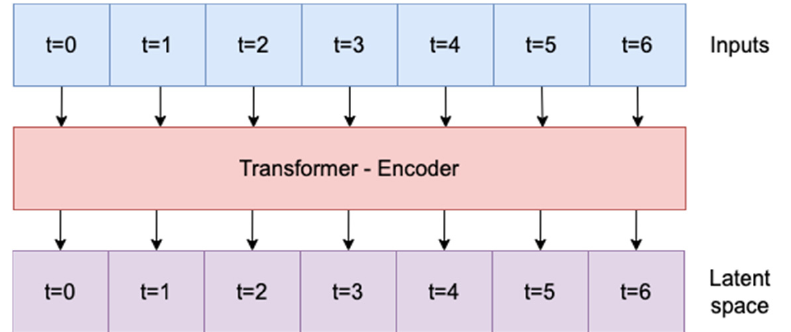
Figure 6. Principle of prediction for the latent space.